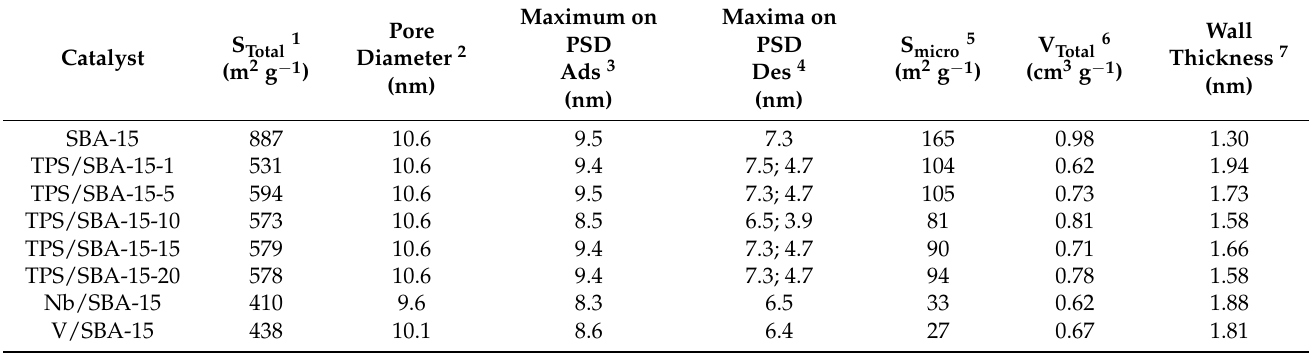
Table 1. Texture/structure characterization and vanadium incorporation